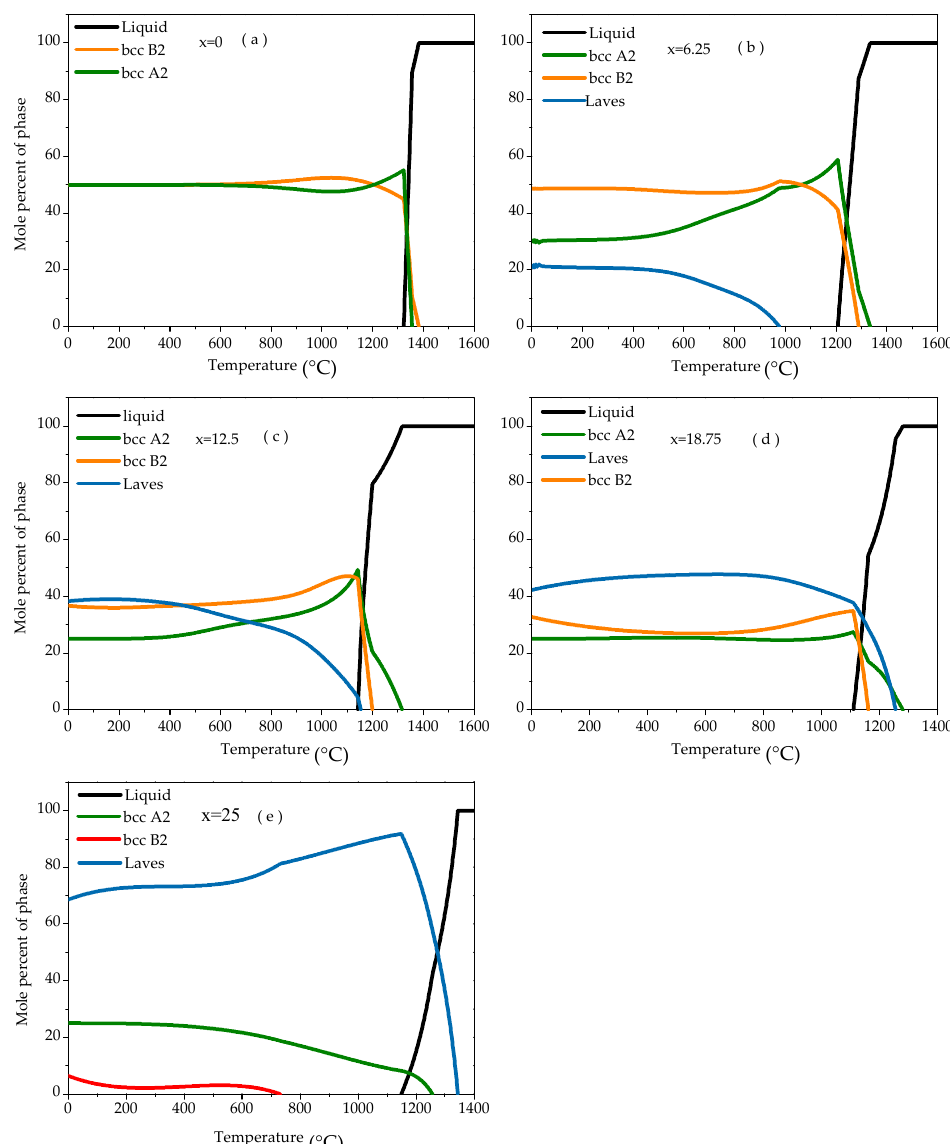
Figure 1. Relationship of phase content and temperature for Fe 25 Cr 25 Ni 25 Ti x Al (25 − x) multi-principle element alloys. ( a ) x = 0; ( b ) x = 6.25; ( c ) x = 12.5; ( d ) x = 18.75; ( e ) x = 25. Table 1. The molar percentage of each phase of the Fe 25 Cr 25 Ni 25 Ti x Al (25-x) alloy at 800 °C. Mole Percent of Phase Alloys